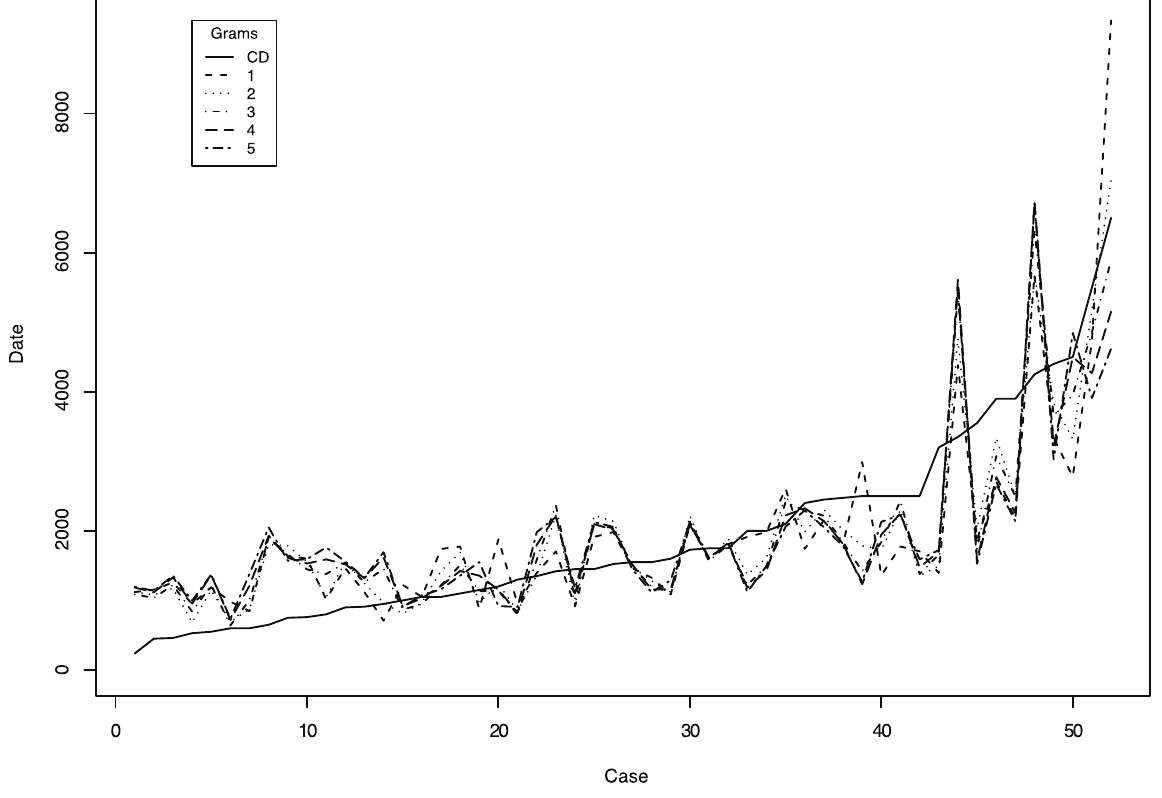
Figure 3. Comparing predicted dates for various n-grams.